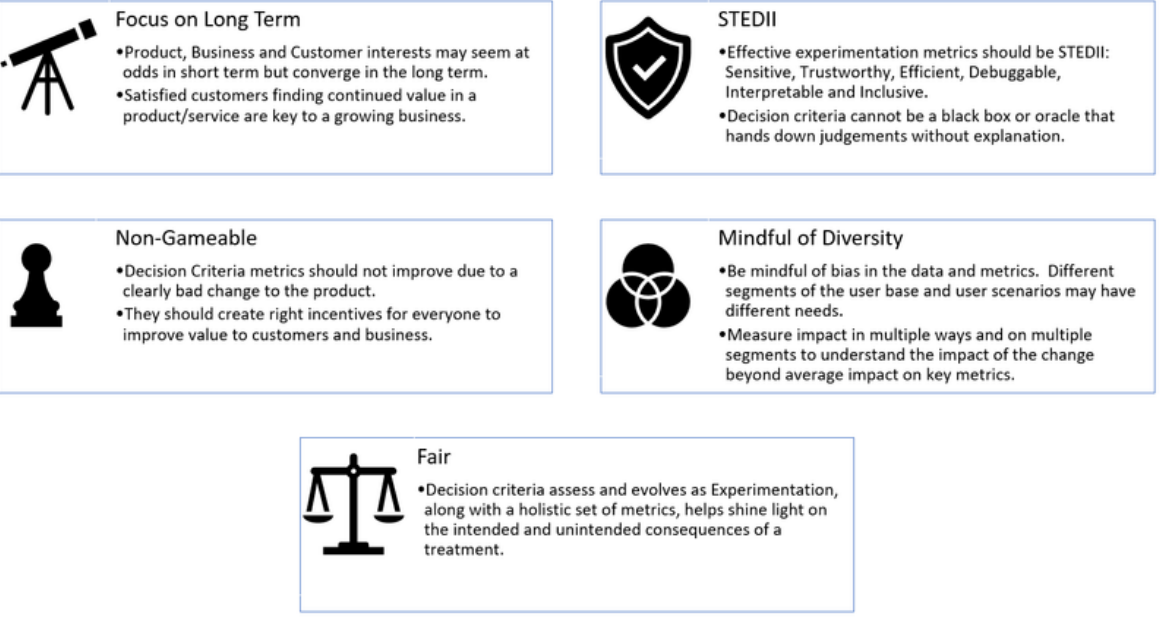
Figure 5. Properties of a good decision criterion (Gupta, Kohavi, et al., 2018; Gupta & Machmouchi, 2022; Kohavi et al.,